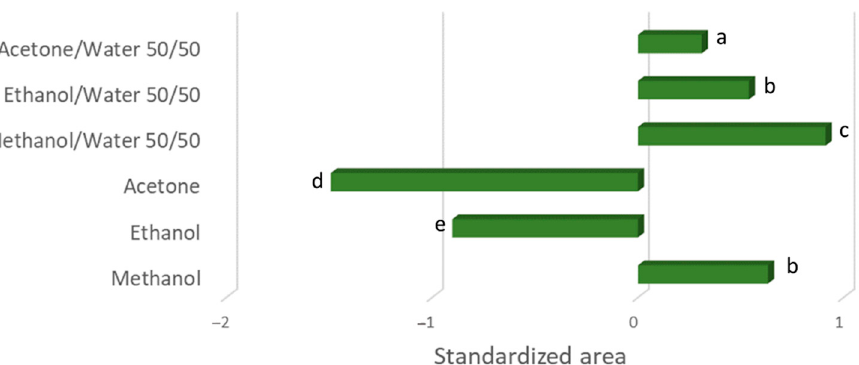
Figure 1. Mean ( n = 3) of the standardized areas of chromatographic peaks for the extraction process using different solvents. Bars with different letters indicate significant differences ( p < 0.05) .